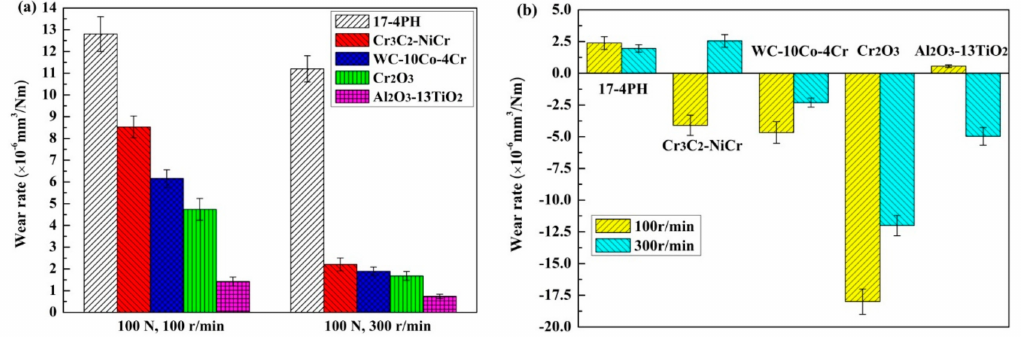
Figure 4. The wear rates of several tribopairs: ( a ) wear rates of CF-PEEK polymers and ( b ) wear rates of 17-4PH and several cermet